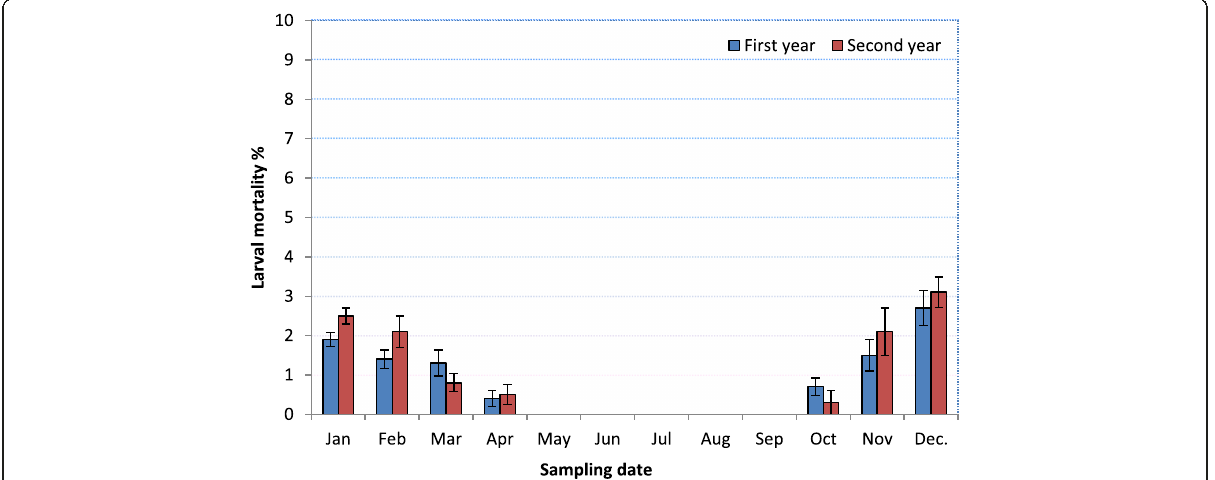
Fig. 2 Seasonal prevalence of Beauveria bassiana in Zeuzera pyrina larvae in olives farm, throughout two seasons (2015-2016 & 2016-2017)